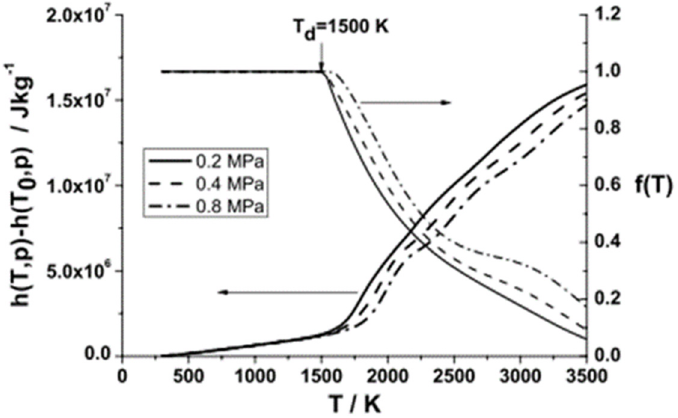
Figure 3. Material functions f(T) and h(T,p) for SF 6 gas [32]. The variation in temperature T can be fed into the following equation to find the new value of E ( z ) ahead of the protrusion.